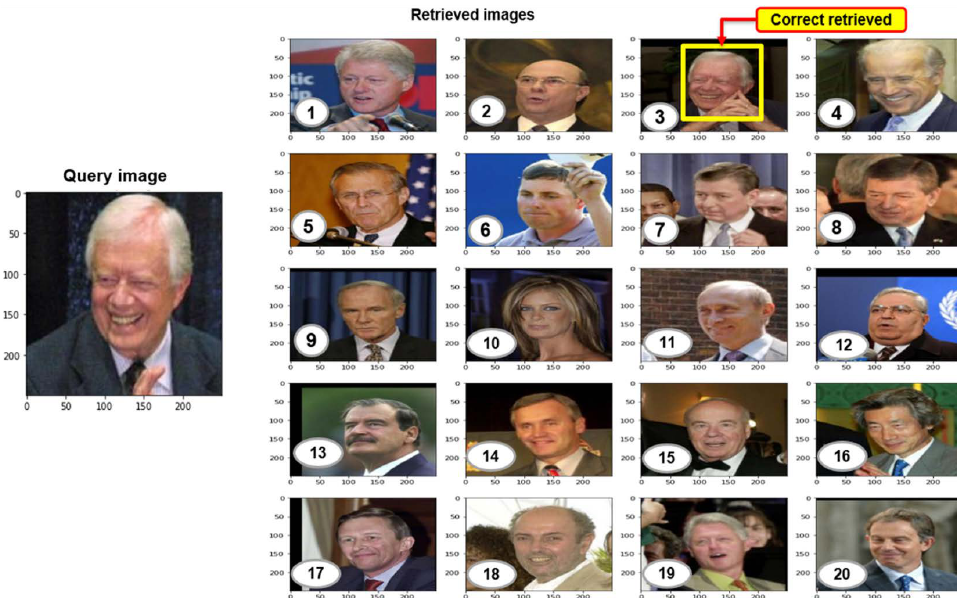
Figure 7. Example of top 20 retrieval results of a query image that correctly retrieved at rank